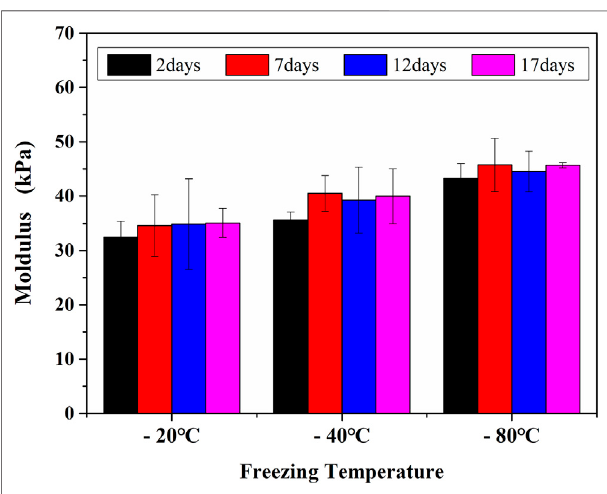
FIGURE 7 | The moldulus of GelMA hydrogels with different freezing temperatures and